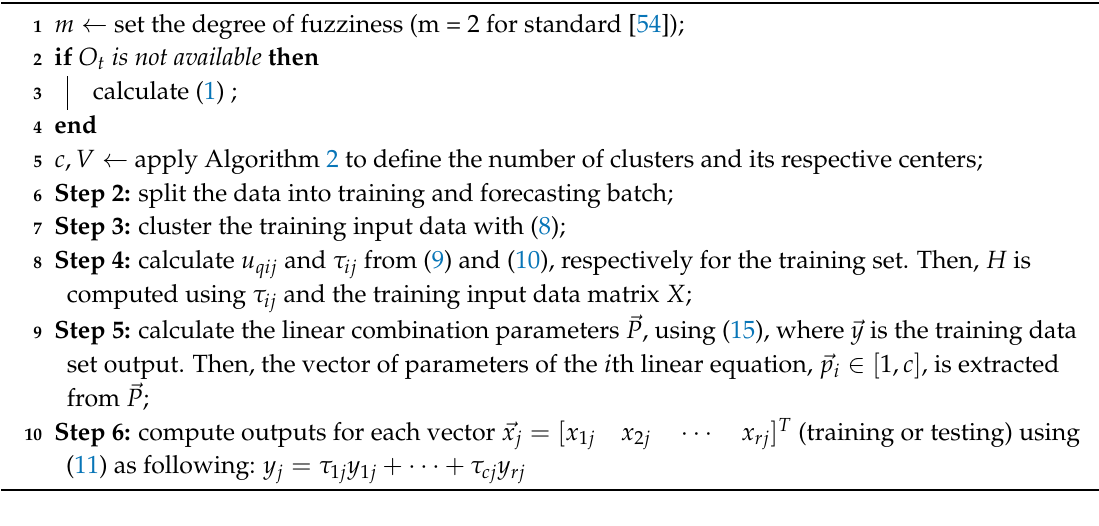
Algorithm 3: Clustering Fuzzy Time Series